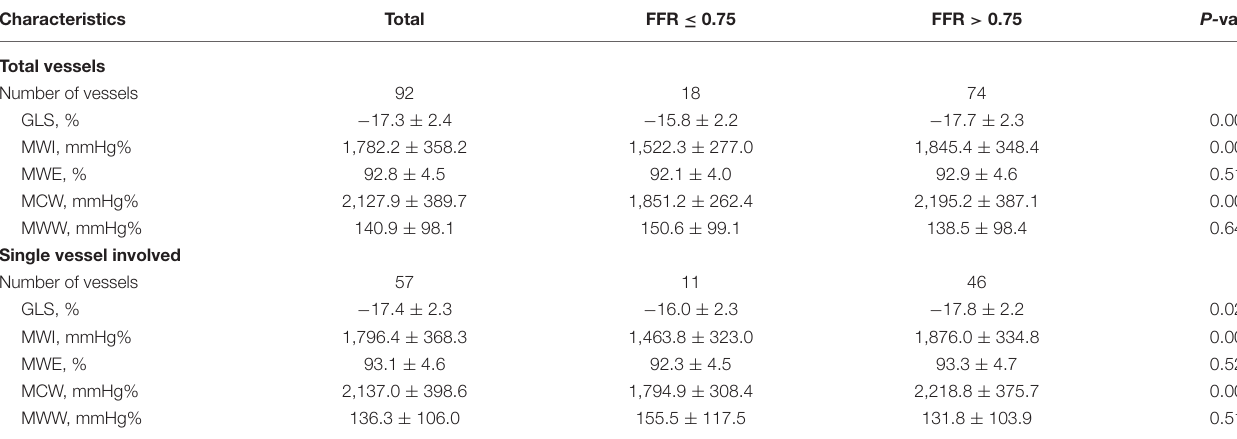
TABLE 2 | Comparing MW parameters and GLS between the FFR ≤ 0.75 and FFR > 0.75 groups. Characteristics Total FFR ≤ 0.75 FFR > 0.75 P- value